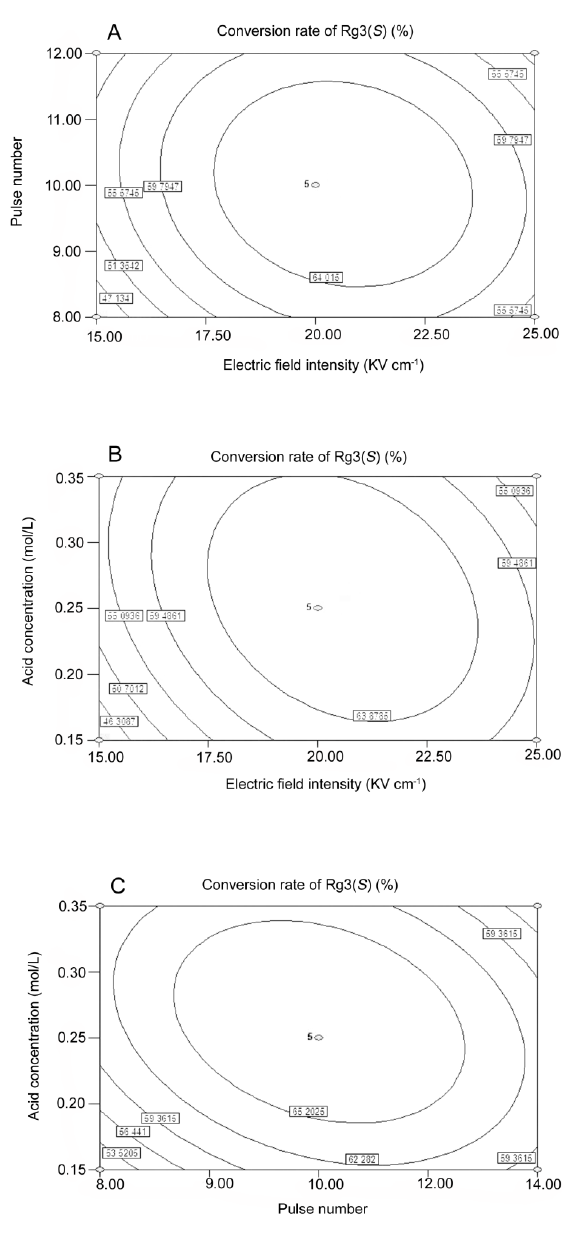
Figure 7. Figure 7 : Contour plot of electric field intensity, pulse duration and acid concentration for producing ginsenoside Rg3( S ) under PEF treatment (a) Electric field intensity and pulse number (b) Electric field intensity and acid concentration (c) Pulse number and acid concentration.